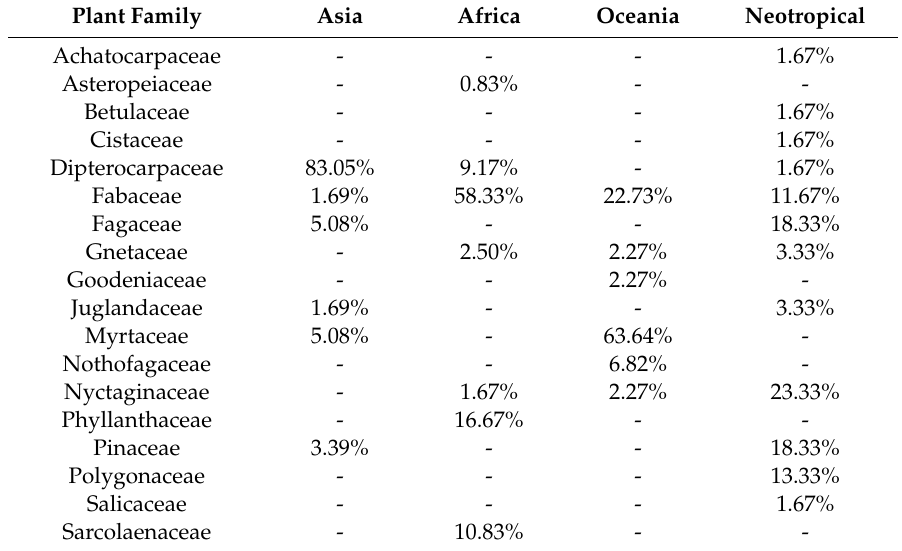
Table 2. A ffi liation of host plant to families at di ff erent geographic regions (adopted from [4]). Plant